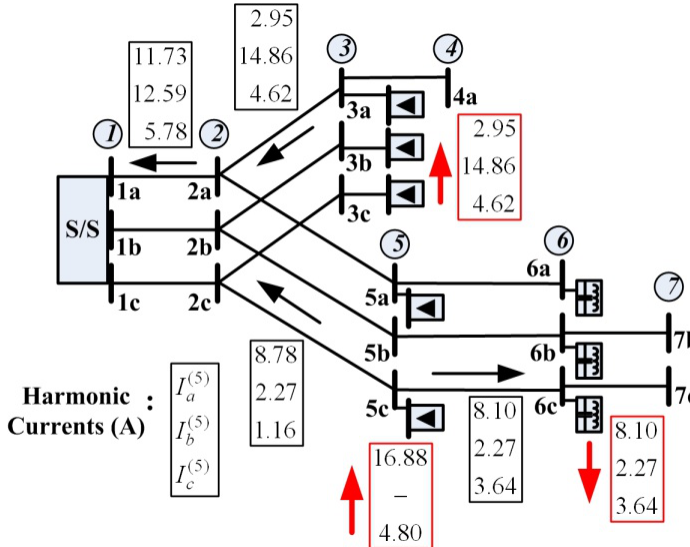
Figure 6. Branch currents of the 5 th -order harmonic order after harmonic filter parameter adjustment.